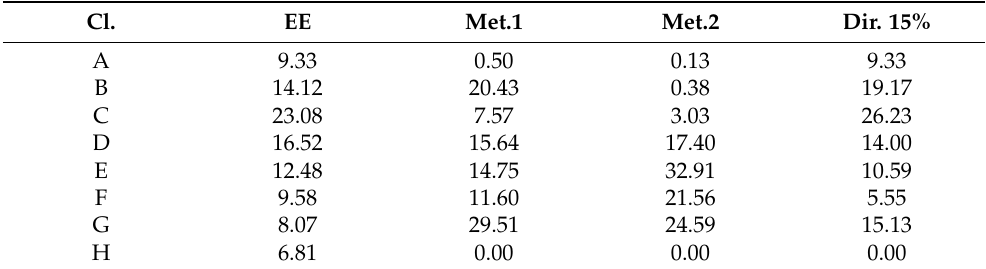
Table A4. EPC certificates % per energy class, as allocated by the different methods, office buildings. Cl.